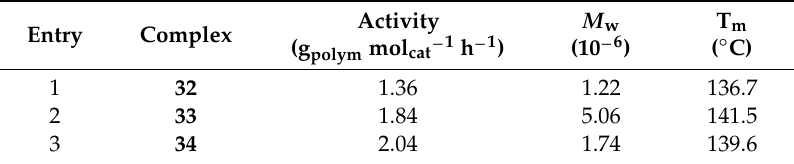
Table 9. Polymerization of ethylene catalyzed by 32–34 / MAO systems [16].